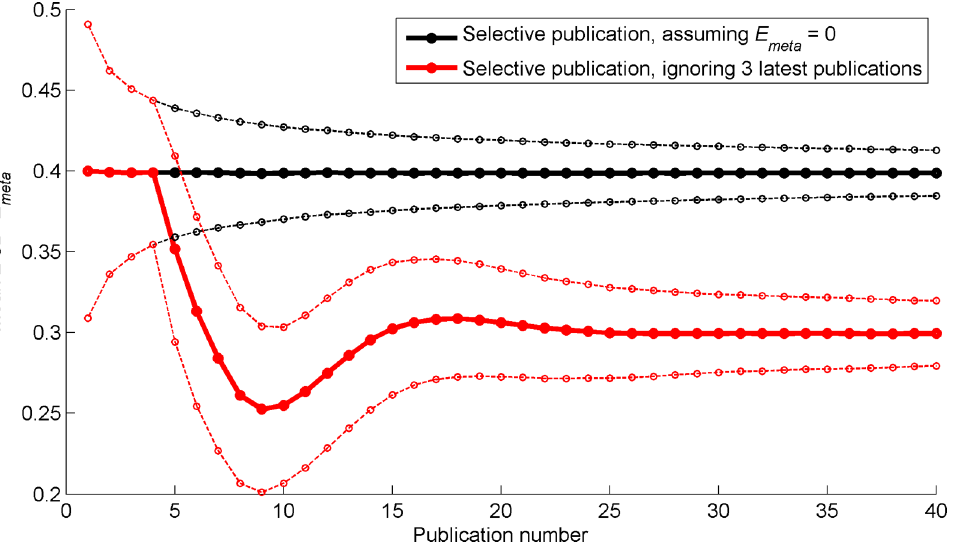
Figure 6. Mean (thicker solid lines) and mean plus/minus one standard deviation (thinner dashed lines) of cumulative meta- analytic effect as a function of the number of publications. The black lines represent the situation where E obs is tested with respect to 0. The red lines represent the situation when ignoring the 3 latest publications for determining E meta . The means and standard deviations are calculated across the 5,000 repetitions of the